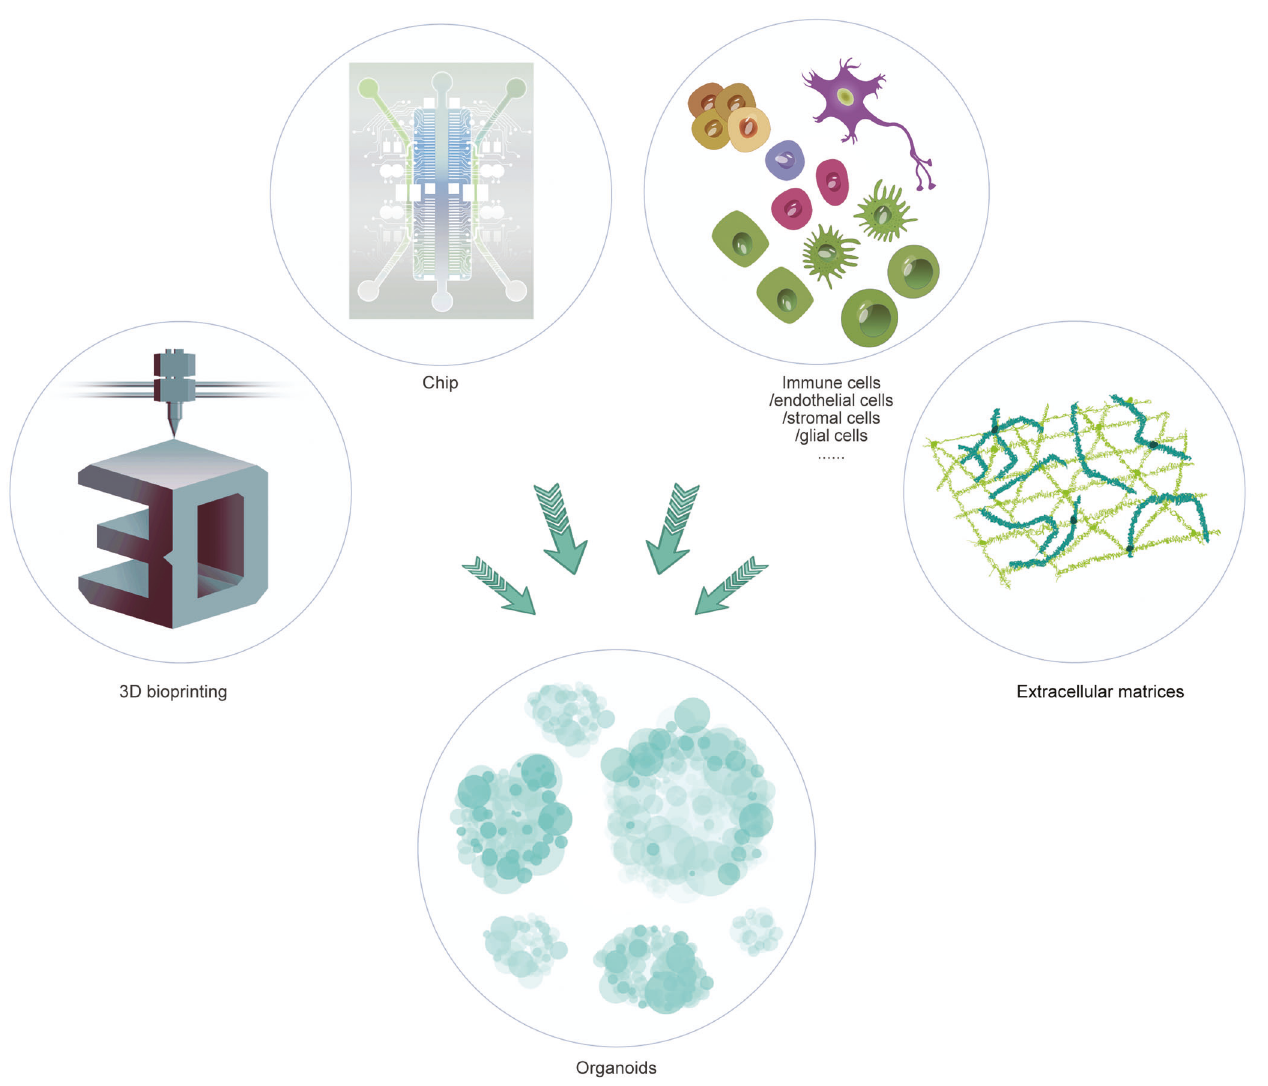
Fig. 4 Advancements in organoid cellular and functional integrity. Advancement of organoid models: improving organoid complexity by adding mesenchymal cells, immune cells, endothelial cells, nerve cells, etc.; combining organoids with 3D bioprinting, biological materials and chip technology to develop organoid models that closely resemble the physiology of the human digestive